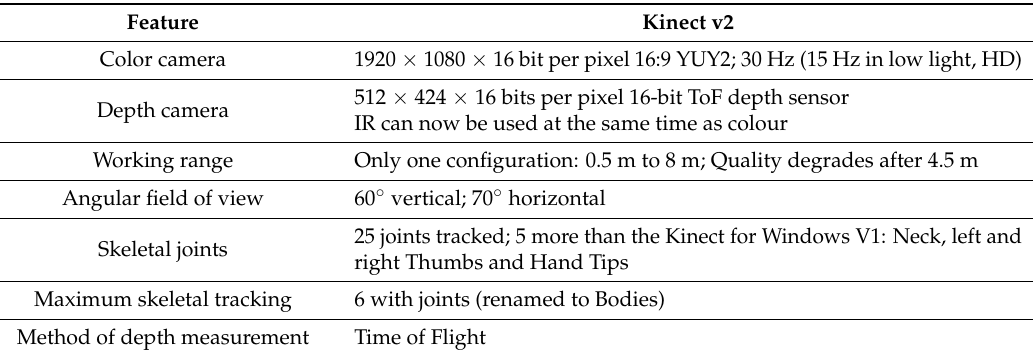
Table 1. Technical specification of the Kinect v2 sensor.